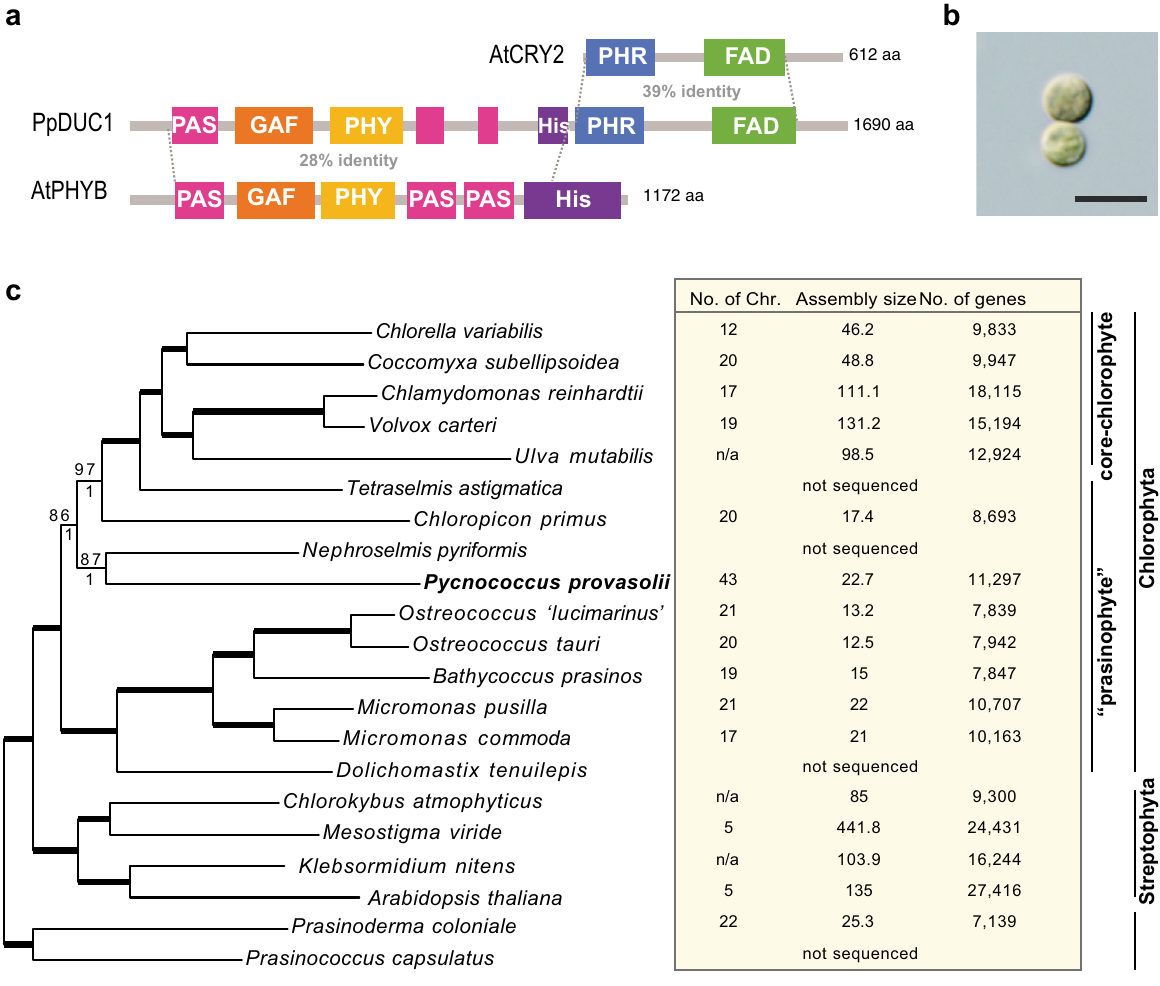
Fig. 1 Chimeric photoreceptor PpDUC1 and phylogeny of its host P. provasolii . a Domain conservation between PpDUC1 and Arabidopsis CRY2 and PHYB. Domain structure of PpDUC1 constructed with PAS: Per-Arnt-Sim, GAF: cGMP-speci fi c phosphodiesterases, adenylyl cyclases and FhlA. PHY: phytochrome, His: histidine kinase domain, PHR: photolyase-homologous region, and FAD: fl avin adenine dinucleotide. b Light microscopic image of coccoid cells of P. provasolii NIES-2893. Scale bar = 5 µ m. Observations were repeated more than three times and representative cells are shown. c Phylogeny of P. provasolii and genome statistics of the main lineages of Viridiplantae. Maximum likelihood (ML) tree of 105 orthologous proteins. The dataset was composed of 41,023 amino acids from 21 species that have genomes available, including P. provasolii . Bootstrap percentages (BPs) and Bayesian posterior probabilities (BPP) are shown above and below the lines, respectively. Bold lines show BP = 100 and BPP